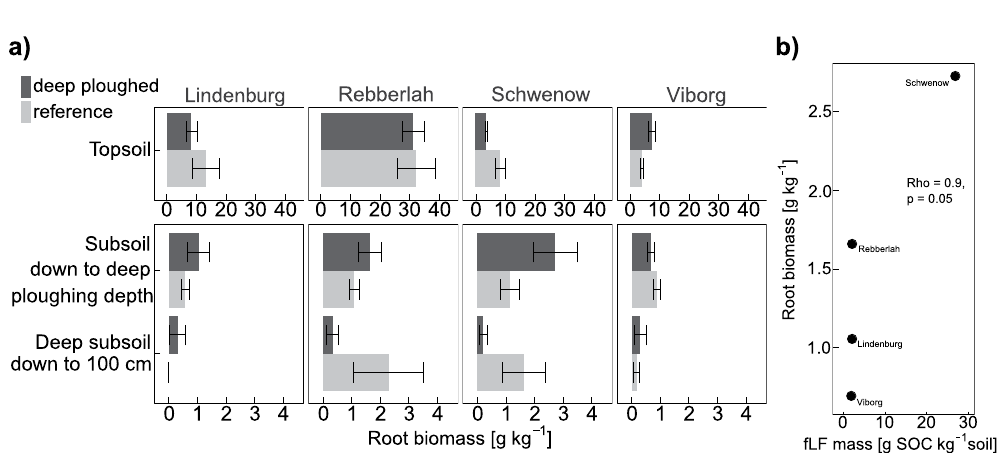
Figure 5. ( a ) Root biomass at different soil depth increments in deep-ploughed and reference forest soil. Bars represent average root biomass in soil cores (n = 5), whiskers show standard error. ( b ) Correlation between root biomass in deep-ploughed subsoil and fLF mass calculated as Spearman’s rank